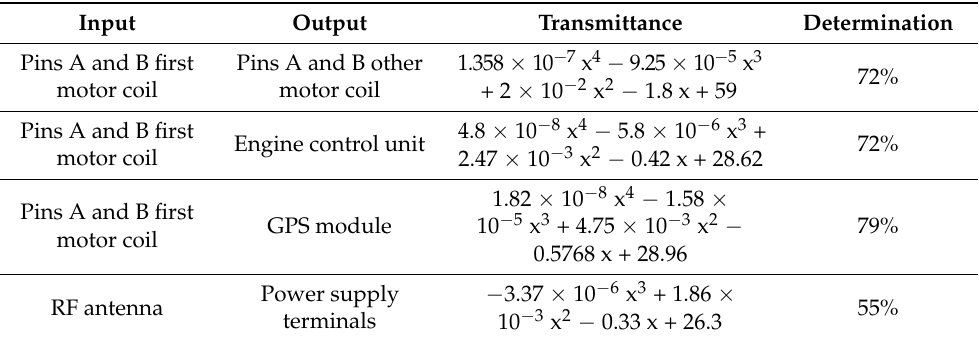
Table 2. Approximation of the transmittance of selected drone circuits, together with the coefficient of